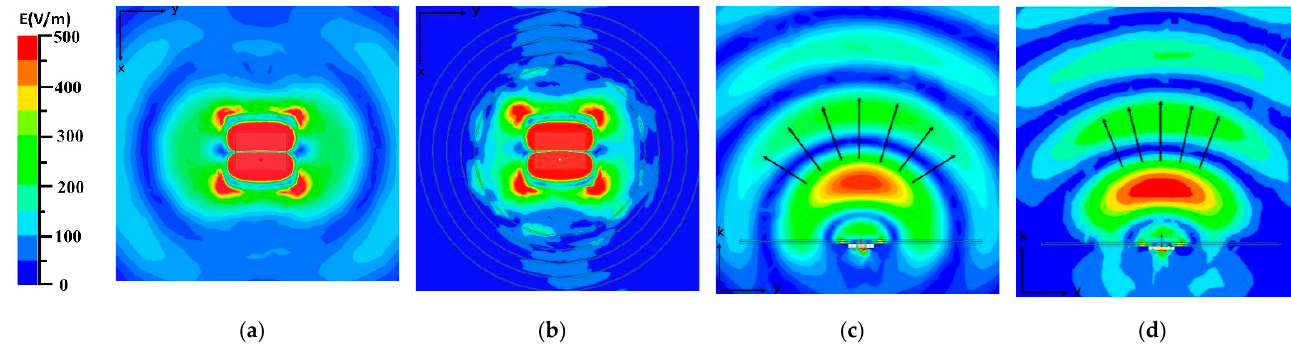
Figure 3. Simulated electric field distribution: ( a , c ) MPA in the horizontal and vertical plane; ( b , d ) MPA loaded with NPMMs in the horizontal and vertical plane.